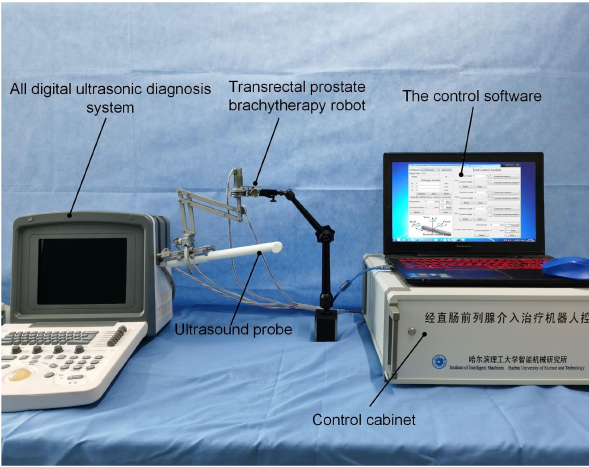
Figure 10. The physical prototype of the transrectal BT robot.